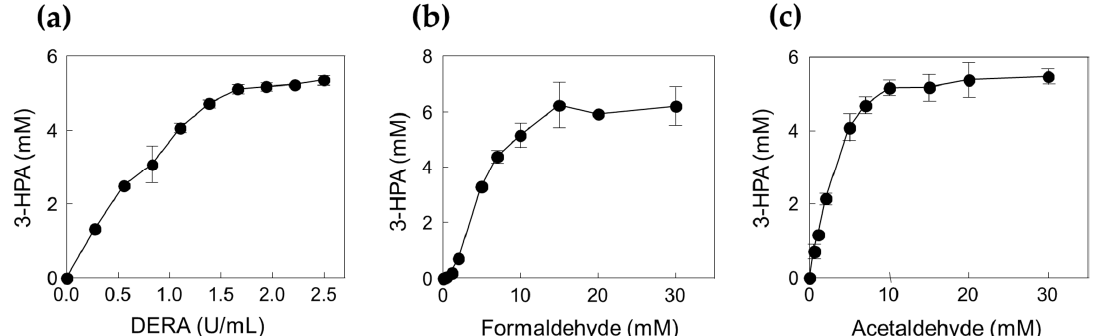
Figure 3. Effects of DERA Tma enzyme and substrate concentrations for the 3-HPA production. ( a ) Effect of DERA enzyme concentration. ( b ) Effect of formaldehyde concentration. ( c ) Effect of acetaldehyde concentration. The reactions were performed at 20 mM Kpi buffer (pH 7.0), DERA Tma enzyme, formaldehyde, and acetaldehyde at 40 ◦ C for 120 min. Data represent the means of two separate experiments, and the error bars represent the standard